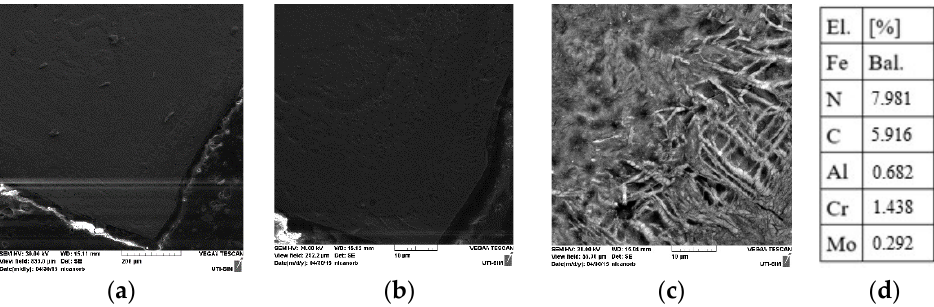
Figure 8. Active screen nitrided sample SEM micrographs, 90° area A, different scale: ( a ) 200 µm, ( b ) 50 µm, ( c ) 10 µm, and ( d ) mass concentration of elements per area.